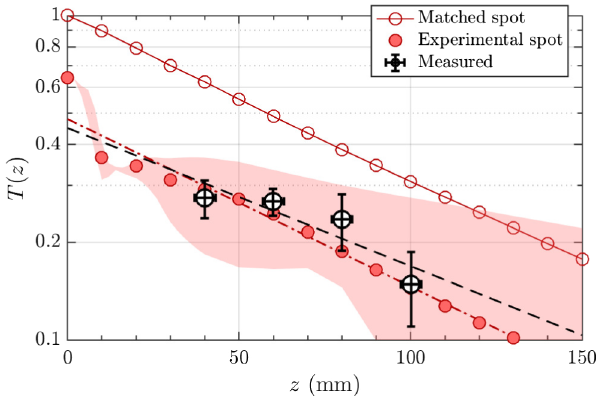
FIG. 5. Comparison of the measured and simulated energy transmission for plasma channels formed at P ¼ 26 mbar and τ ¼ 2 . 7 ns. The measured data is shown as open black circles, with error bars with a total length equal to one standard deviation. ð z Þ ¼ The dashed black line shows a fit of the function T theory T ð 0 Þ exp ð − z=L Þ to the experimental data. The open red circles att show the calculated transmission for a Gaussian input beams with a spot size matched to the lowest-order mode of the channel. The solid red circles show the calculated energy transmission for an input beam with a transverse intensity profile equal to the experimentally measured profile [see Fig. 3(a)]; the red shading shows the uncertainty in T ð z Þ arising from the uncertainties in the electron density profile. The red dash-dot line shows a fit of the ð z Þ to the calculated transmission for the realistic function T theory input spot in the region z > 50